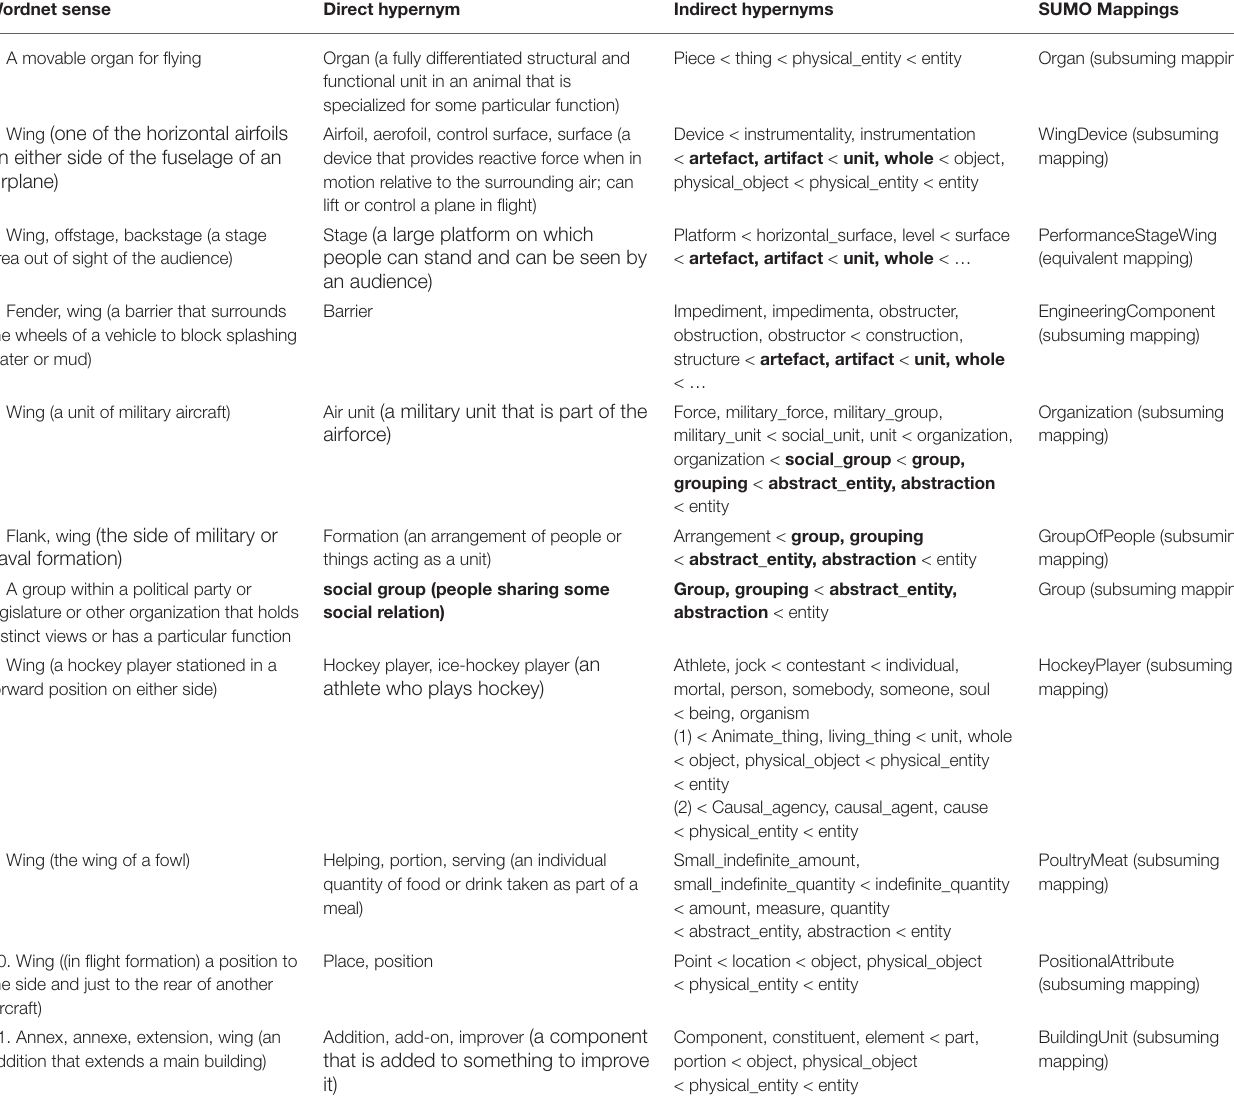
TABLE 2 | WordNet senses with SUMO mappings for the noun “wing” categorized according to hypernyms.